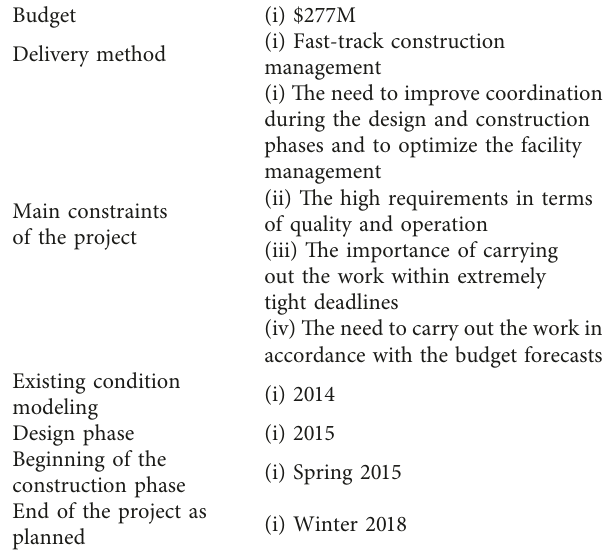
Table 2: Information on the case study. Table 1: Distribution of interviewees.